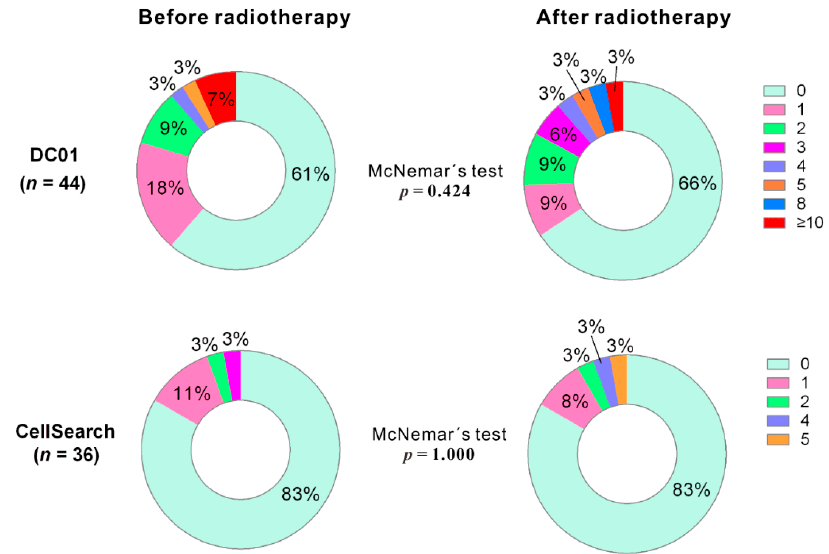
Figure 4. Distribution of circulating tumor cell (CTC) counts detected by DC01 and CellSearch at two sampling time points (i.e., 1 day before commencing radiotherapy and 3 months after completion of radiotherapy) ( p < 0.05 statistically significant, two-tailed, McNemar’s test). 2.5. DC01 Improves CTC Enrichment E ffi ciency in A Cohort of High-Risk Non-Metastatic PCa Patients